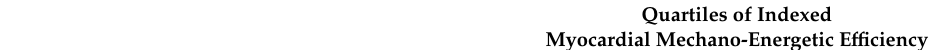
Characteristics of quartiles of LV mass-normalized myocardial mechano-energetic e ffi ciency